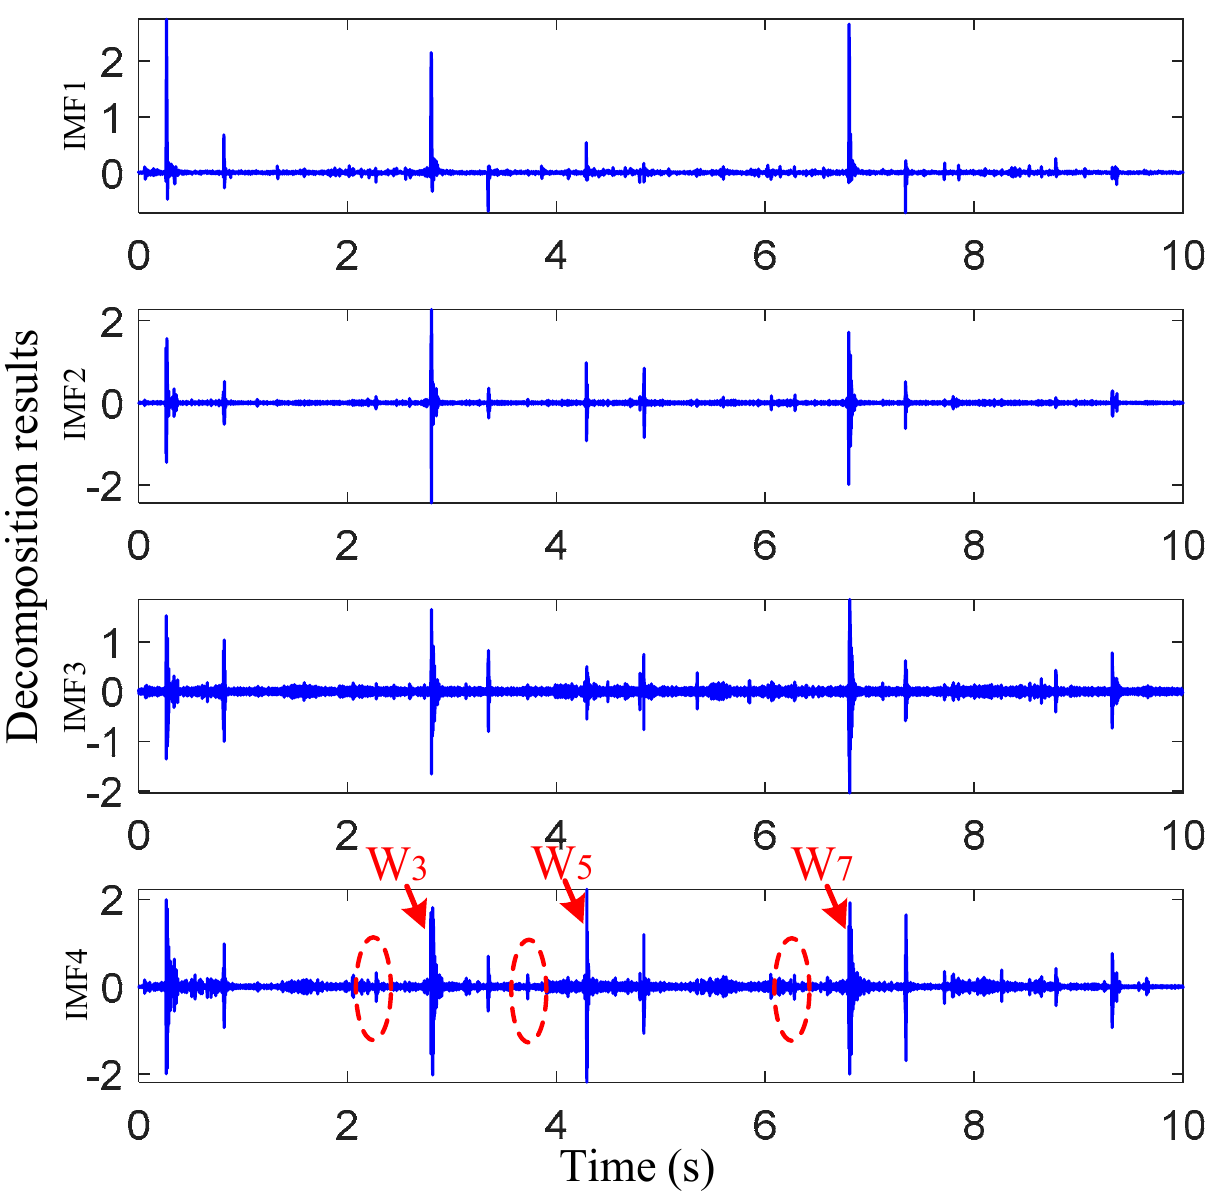
Figure 7. Vibration response of measuring point 1 under 17.1 km/h excitation. Figure 8a shows the raw vibrations, the IMF4 component and further results processed through the SS of the preseted 16 km/h experiment of sensor 1. Compared with the VMD results, three impulses with small amplitudes can be easily identified from the VMD-SS method, which are marked with red dotted lines. To analyze the three small impulses, they were defined as I 3 , I 5 and I 7 , respectively. Then, the distances between I 3 - W 3 , I 5 - W 5 and I 7 - W 7 were calculated with the corrected velocity of 17.1 km/h. The calculated results are shown in the fifth row of Table 4. It can be observed that the distance between the small impulses and the joint was basically consistent with the 2.5 m in Figure 4b. Therefore, we assume that the small impulses were caused by the damage-induced impact